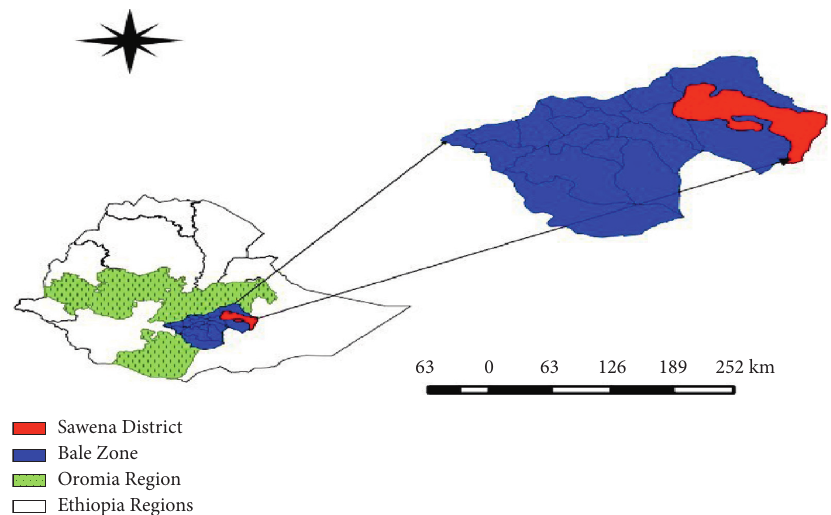
Figure 1: Map of the study